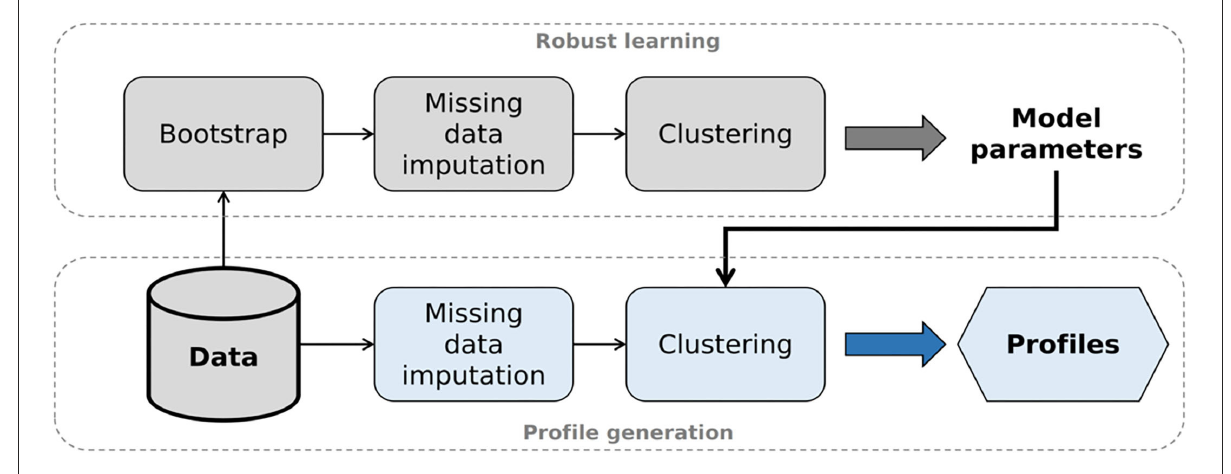
FIGURE1 Analysis pipeline to generate auditory profiles. After selecting the optimal model parameters (robust learning, upper part), model-based clustering is applied to the original data set (profile generation, lower